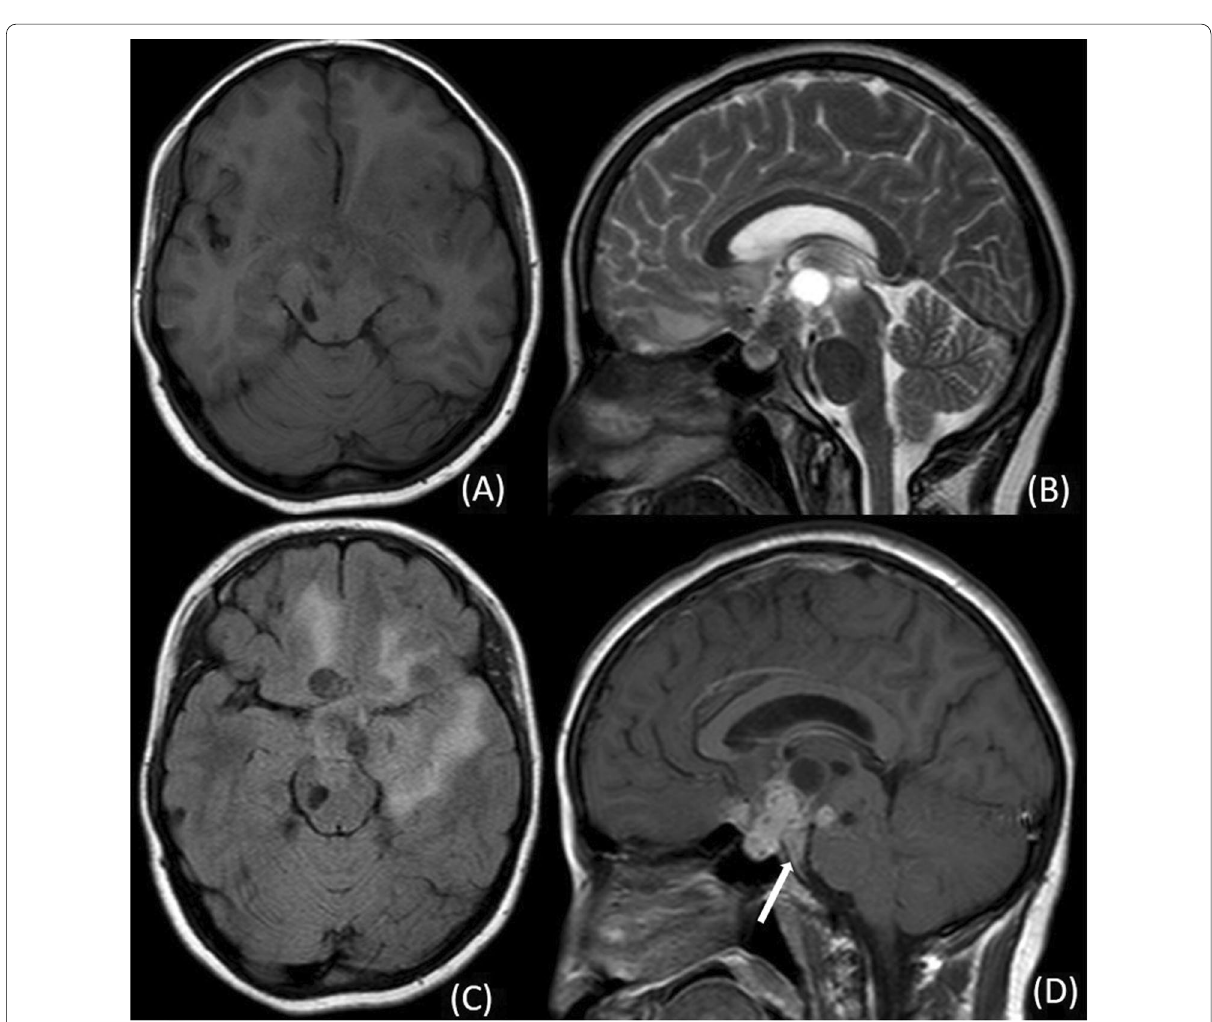
Fig. 1 Pituitary and hypothalamic tubercular granulomas. MRI of a 24-year-old male shows multiple conglomerate lesions in pituitary, hypothalamus and midbrain which appear isointense with hyperintense rim on axial T1W image ( A ), variable signal intensity on T2W image ( B ), extensive surrounding white matter oedema is seen on FLAIR ( C ), on T1 contrast-enhanced image the lesions show peripheral enhancement with basal exudates in prepontine cistern (arrow in D